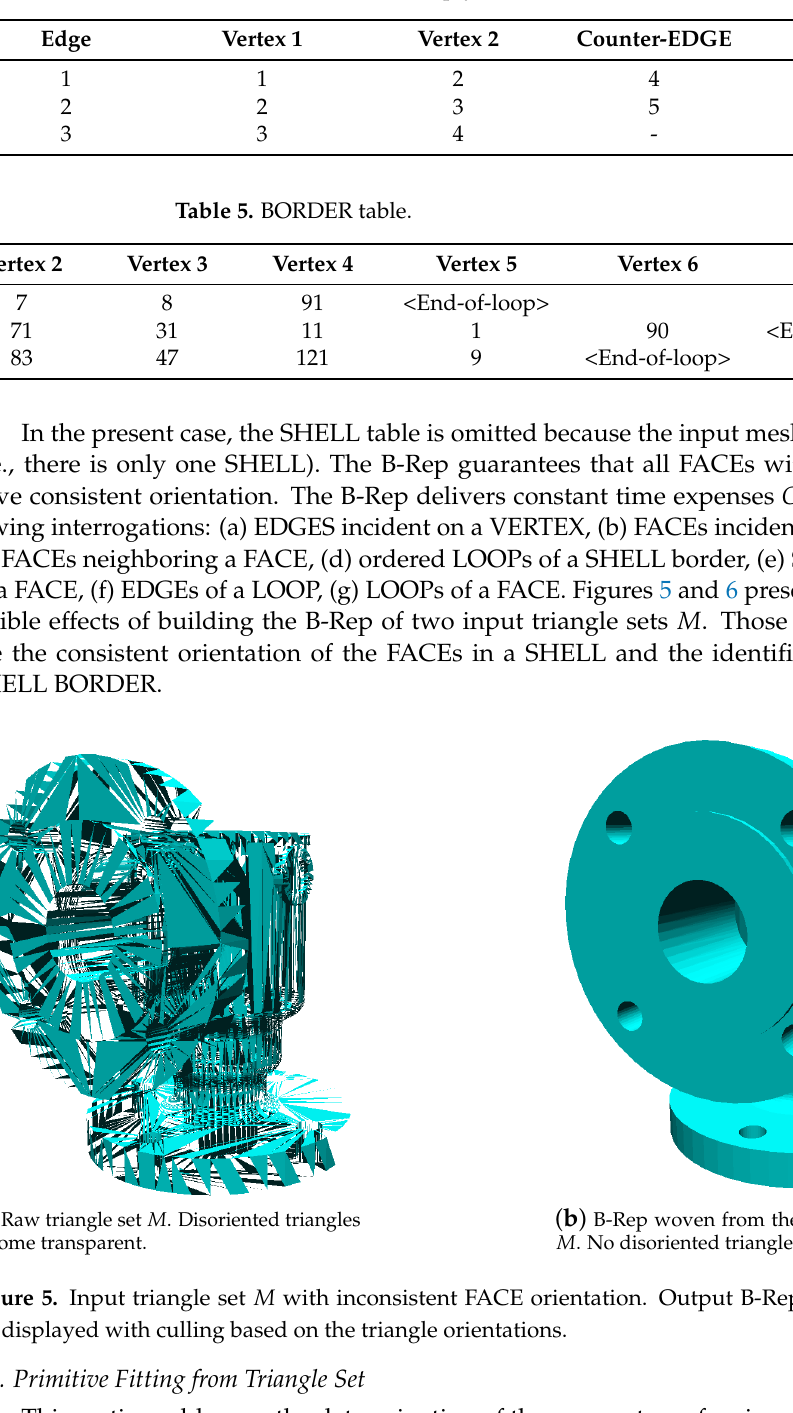
Table 4. EDGE table. If counter-EDGE cell is empty, indicates border.